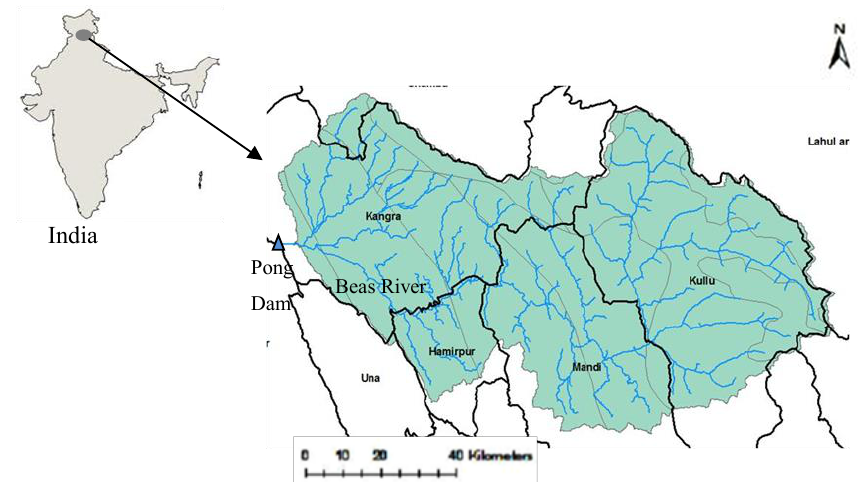
Figure 3. Map of India and the Beas river catchment.